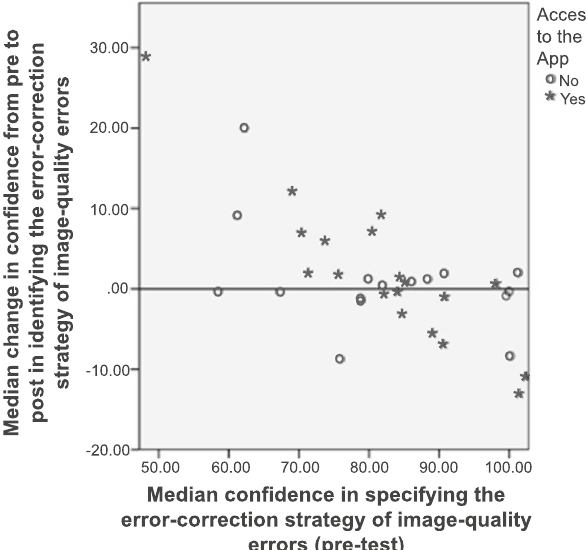
Fig. 4 Scatterplot of median change in confidence level for radiographers in identifying the type of image-quality errors verse pre-test confidence by experimental group